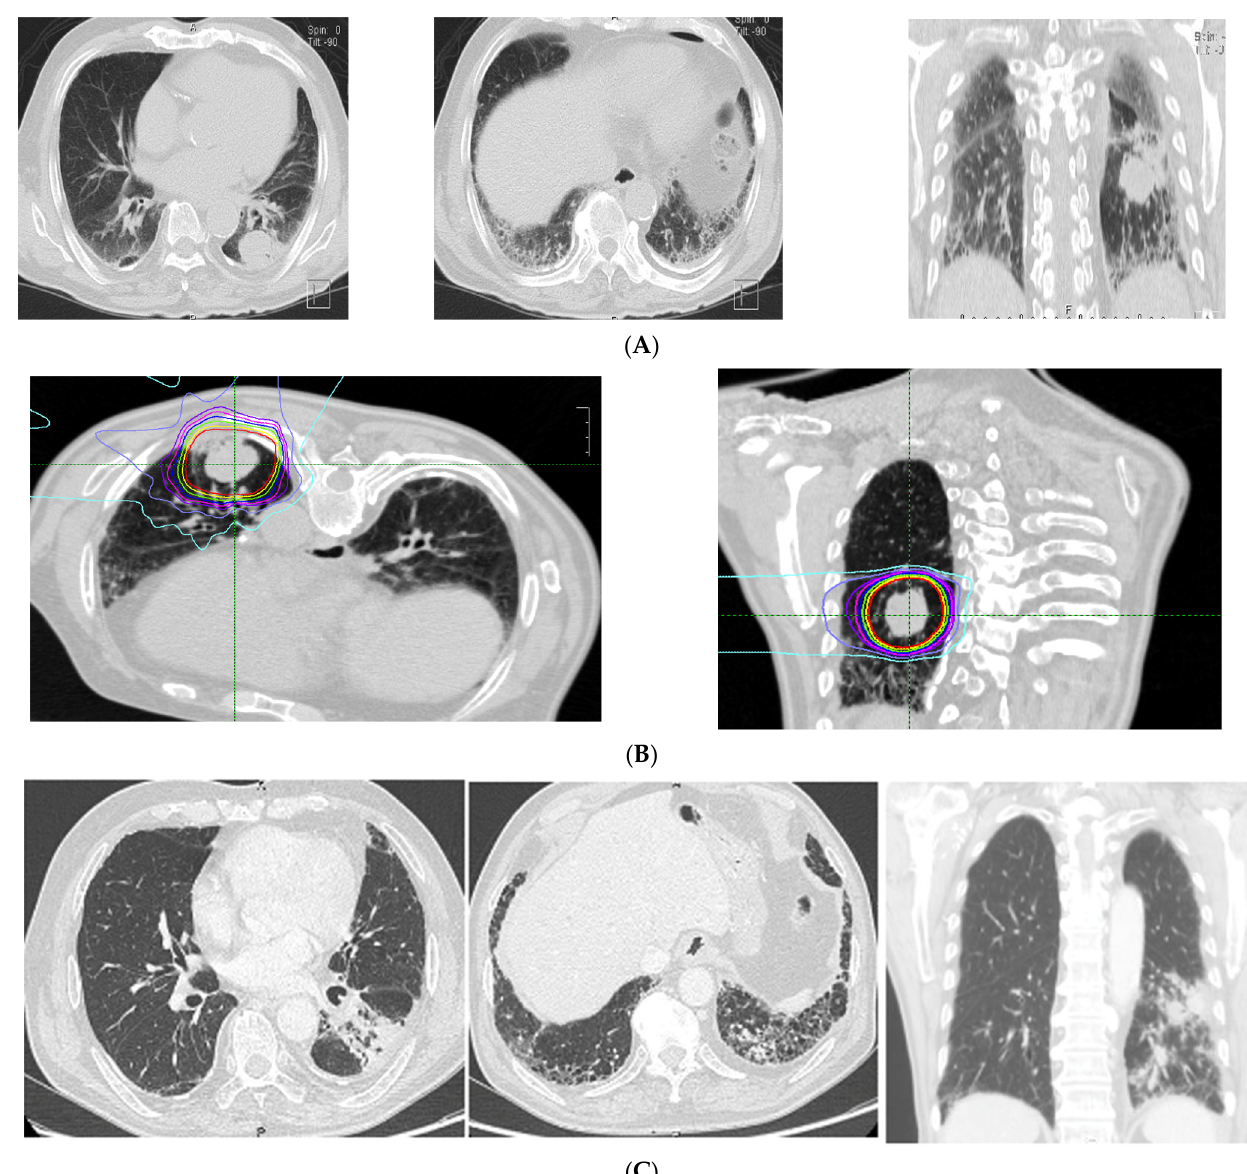
Figure 1. Representative case of imaging findings and dose distributions in the interstitial lung disease (ILD) group. ( A ) pre-treatment CT (diagnosis: usual interstitial pneumonitis (UIP); fibrosis score: 5, GGO score: 0, CT findings: honeycomb, GGO, reticulation, traction bronchitis, emphysema). ( B ) Dose distribution. ( C ) Post-treatment CT (6 months after CIRT).